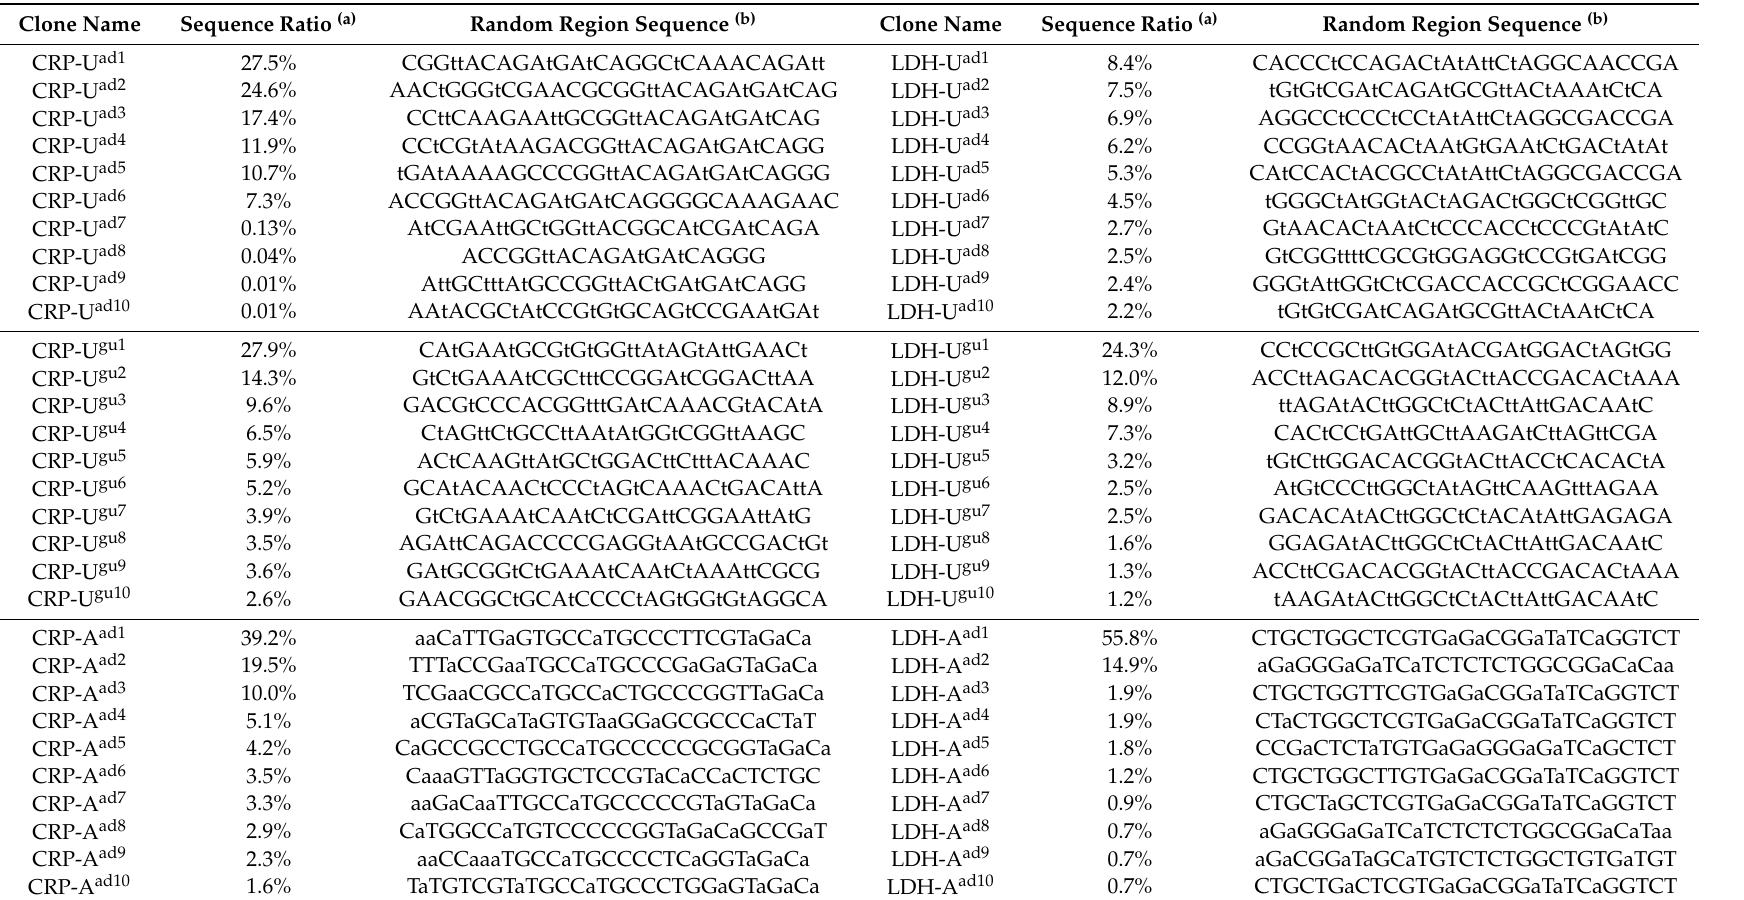
Table A1. The 10 most common sequences in the U ad -, U gu -, and A ad -modified ssDNA